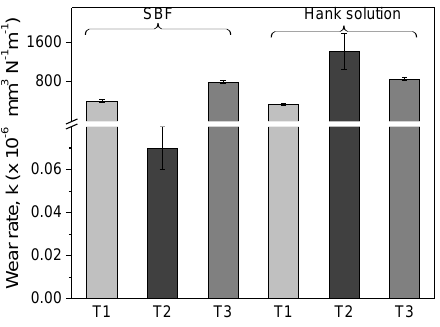
Figure 4. Evolution of the friction coefficients for T1, T2, and T3 alloys vs. sliding distance in ( a ) simulated body fluid (SBF) and ( b ) Hank solution. Figure 5. Mean value of wear rate for T1, T2, and T3 alloys, calculated in four areas on each sample.